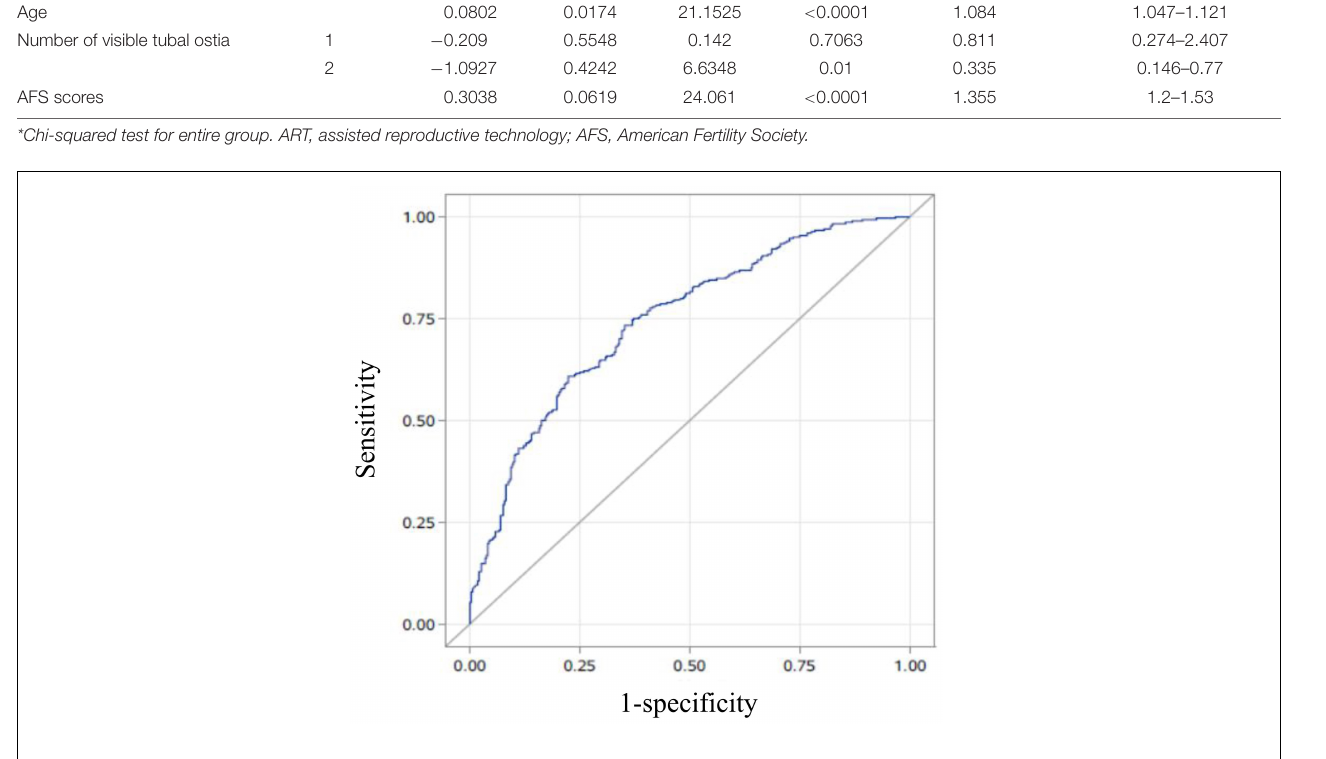
FIGURE 2 | The area under the curve (AUC) of the prediction model. The AUC of the live-birth prediction model (based on pregnancy patterns, age, number of visible tubal ostia, and the American Fertility Society scores in second-look hysteroscopy) was